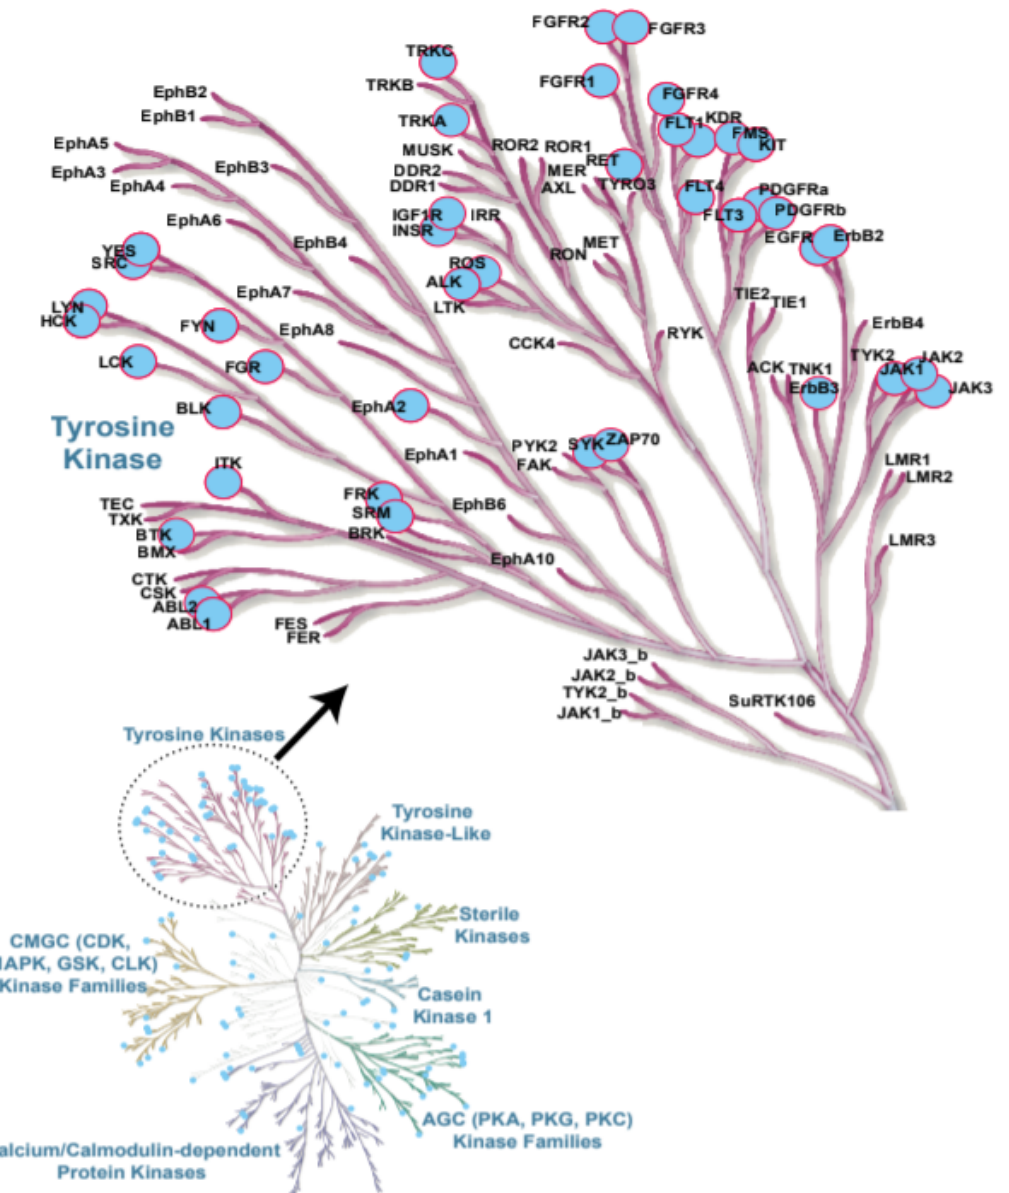
Figure 1. Protein kinases contributing to leukaemia are highlighted in blue. Examples of tyrosine kinases (TKs) involved in leukaemia are shown in the insert [21].